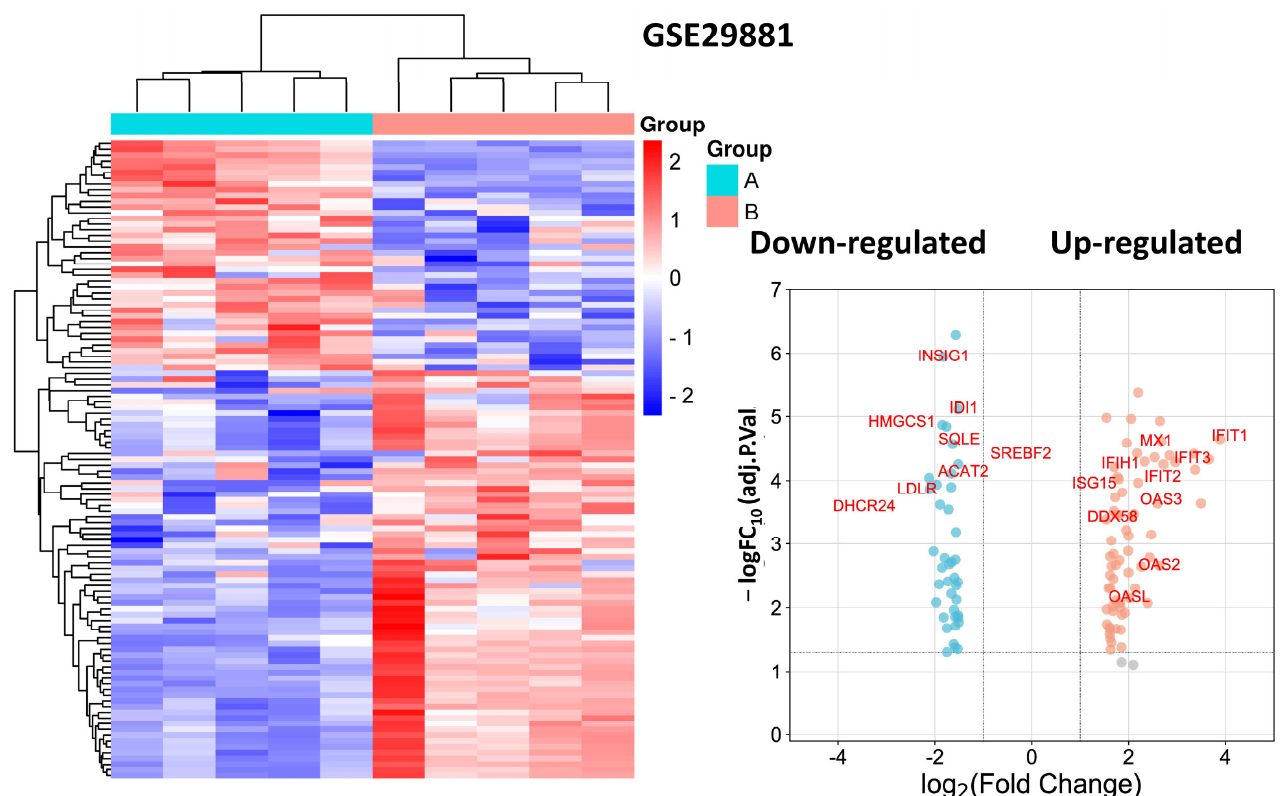
Figure 9. Heatmap and volcano plot for DEGs from dataset GSE29881. Note: the identified hub DEGs are shown in the volcano plot.